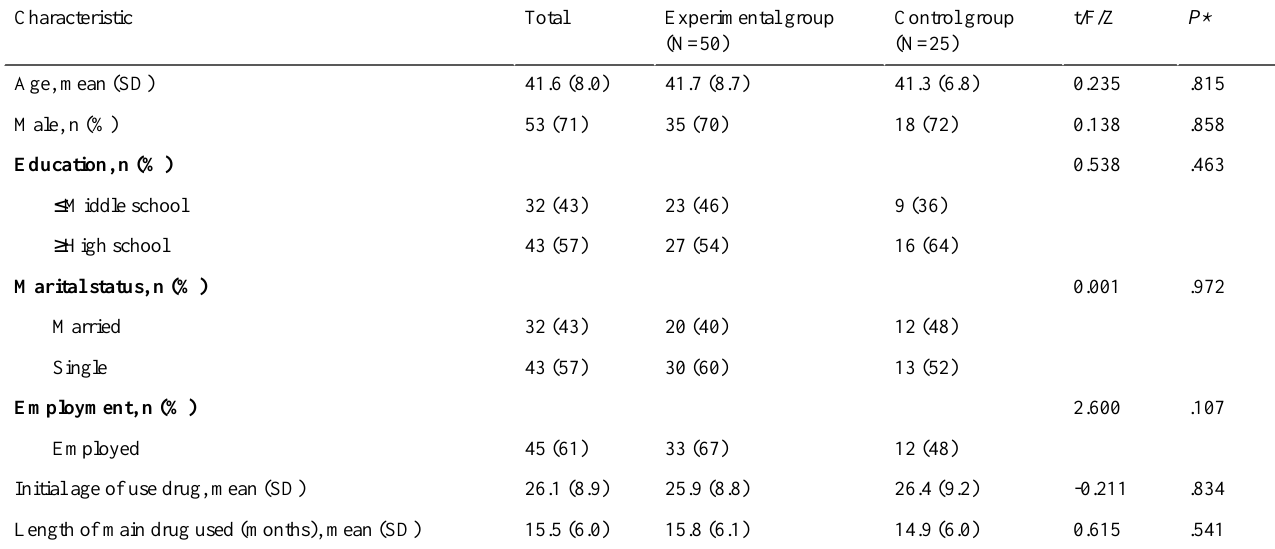
Table 1. Baseline characteristics of the participants